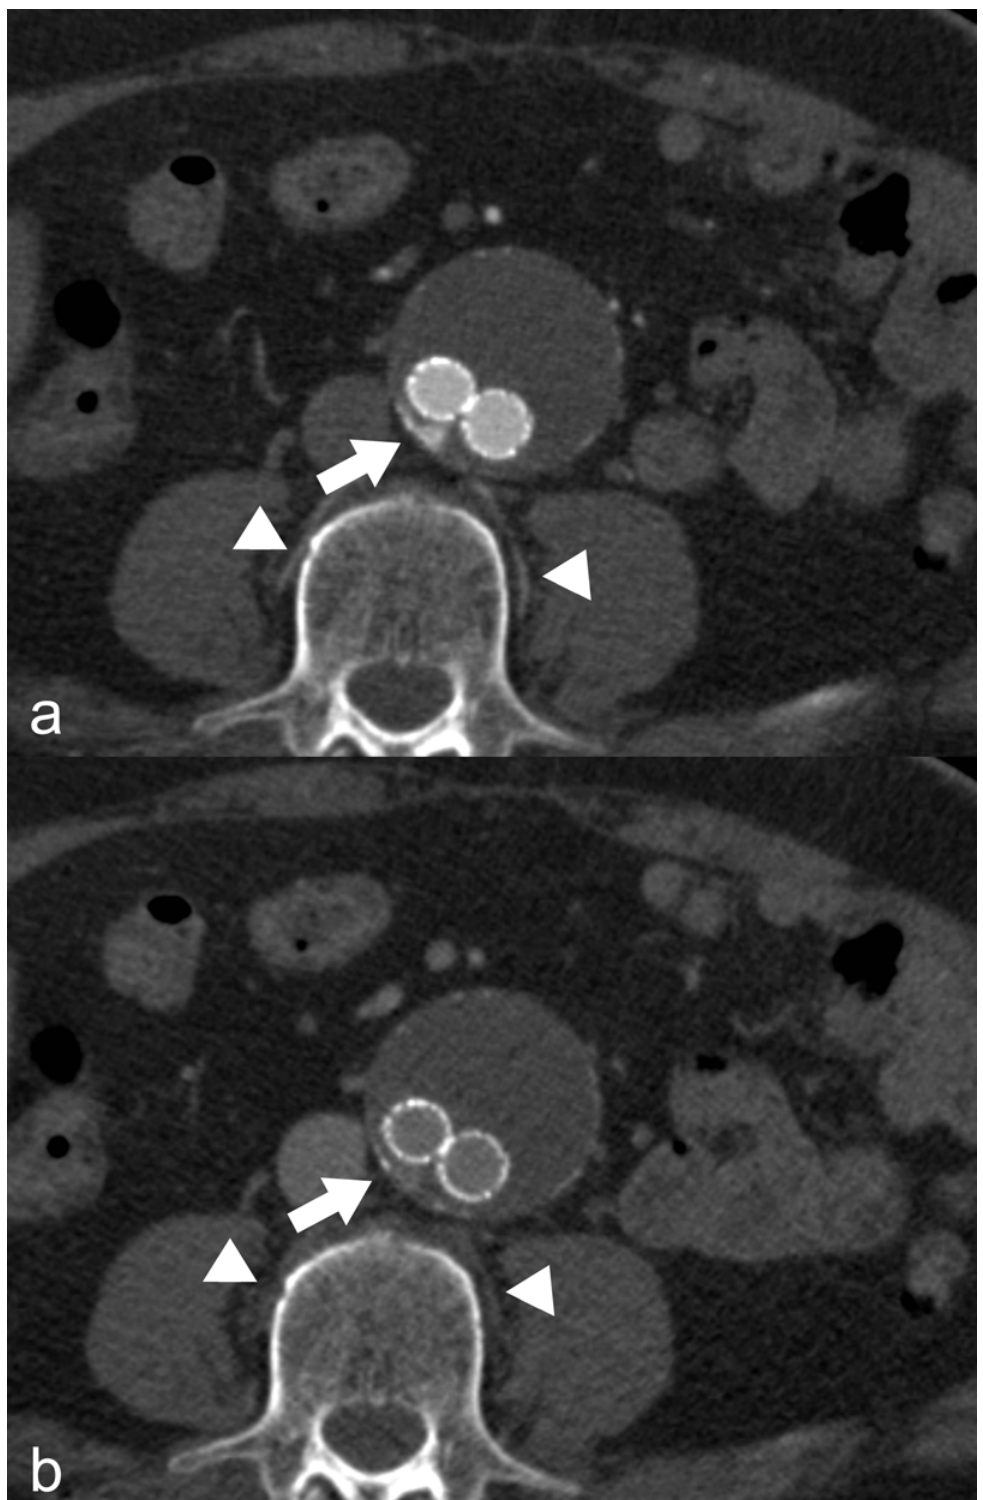
Fig 1. Feeding vessel detection in arterial and venous phase acquisition. (a) Arterial phase acquisition: Clearly perceptible blush of contrast agent in the aneurysm sac (arrow) indicative of the presence of a type 2 endoleak. Consecutive, feeding lumbar arteries of this segment show the same contrast as the aorta (arrowheads). (b) Venous phase acquisition: Similarly, clearly detectable type 2 endoleak (arrow). However, potentially feeding lumbar arteries show no contrast enhancement (arrowheads). doi:10.1371/journal.pone.0149725.g001 PLOS ONE | DOI:10.1371/journal.pone.0149725 March 1,